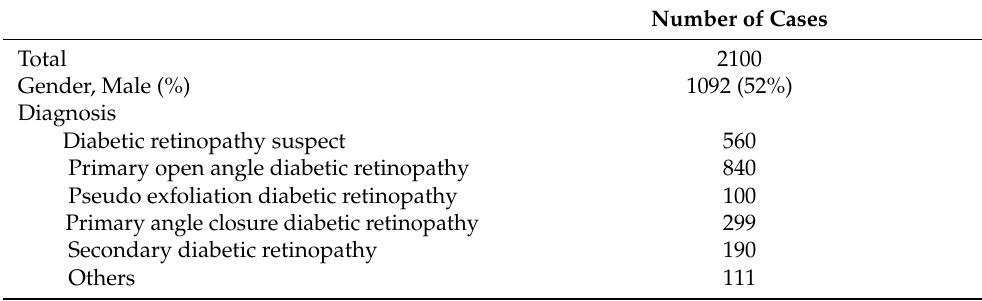
Table 5. Statistics of the test dataset.